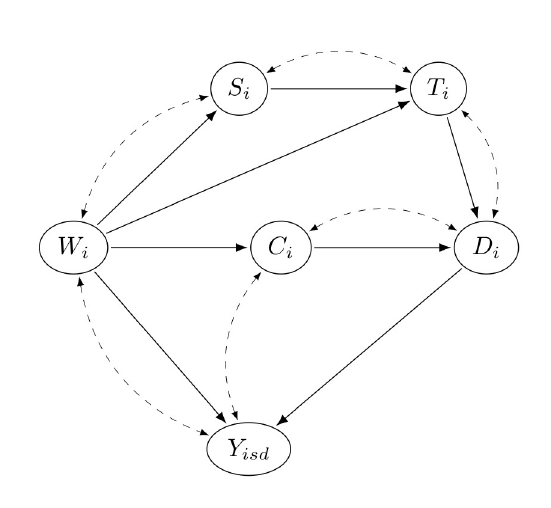
Figure 1: Causal diagram representing the effect of treatment received, D i , on potential outcomes, Y isd . Solid unidirectional arrows represent causal links between observed variables. Dashed bidirectional arrows represent confounding arcs containing only latent variables, which are implicit in the confounding